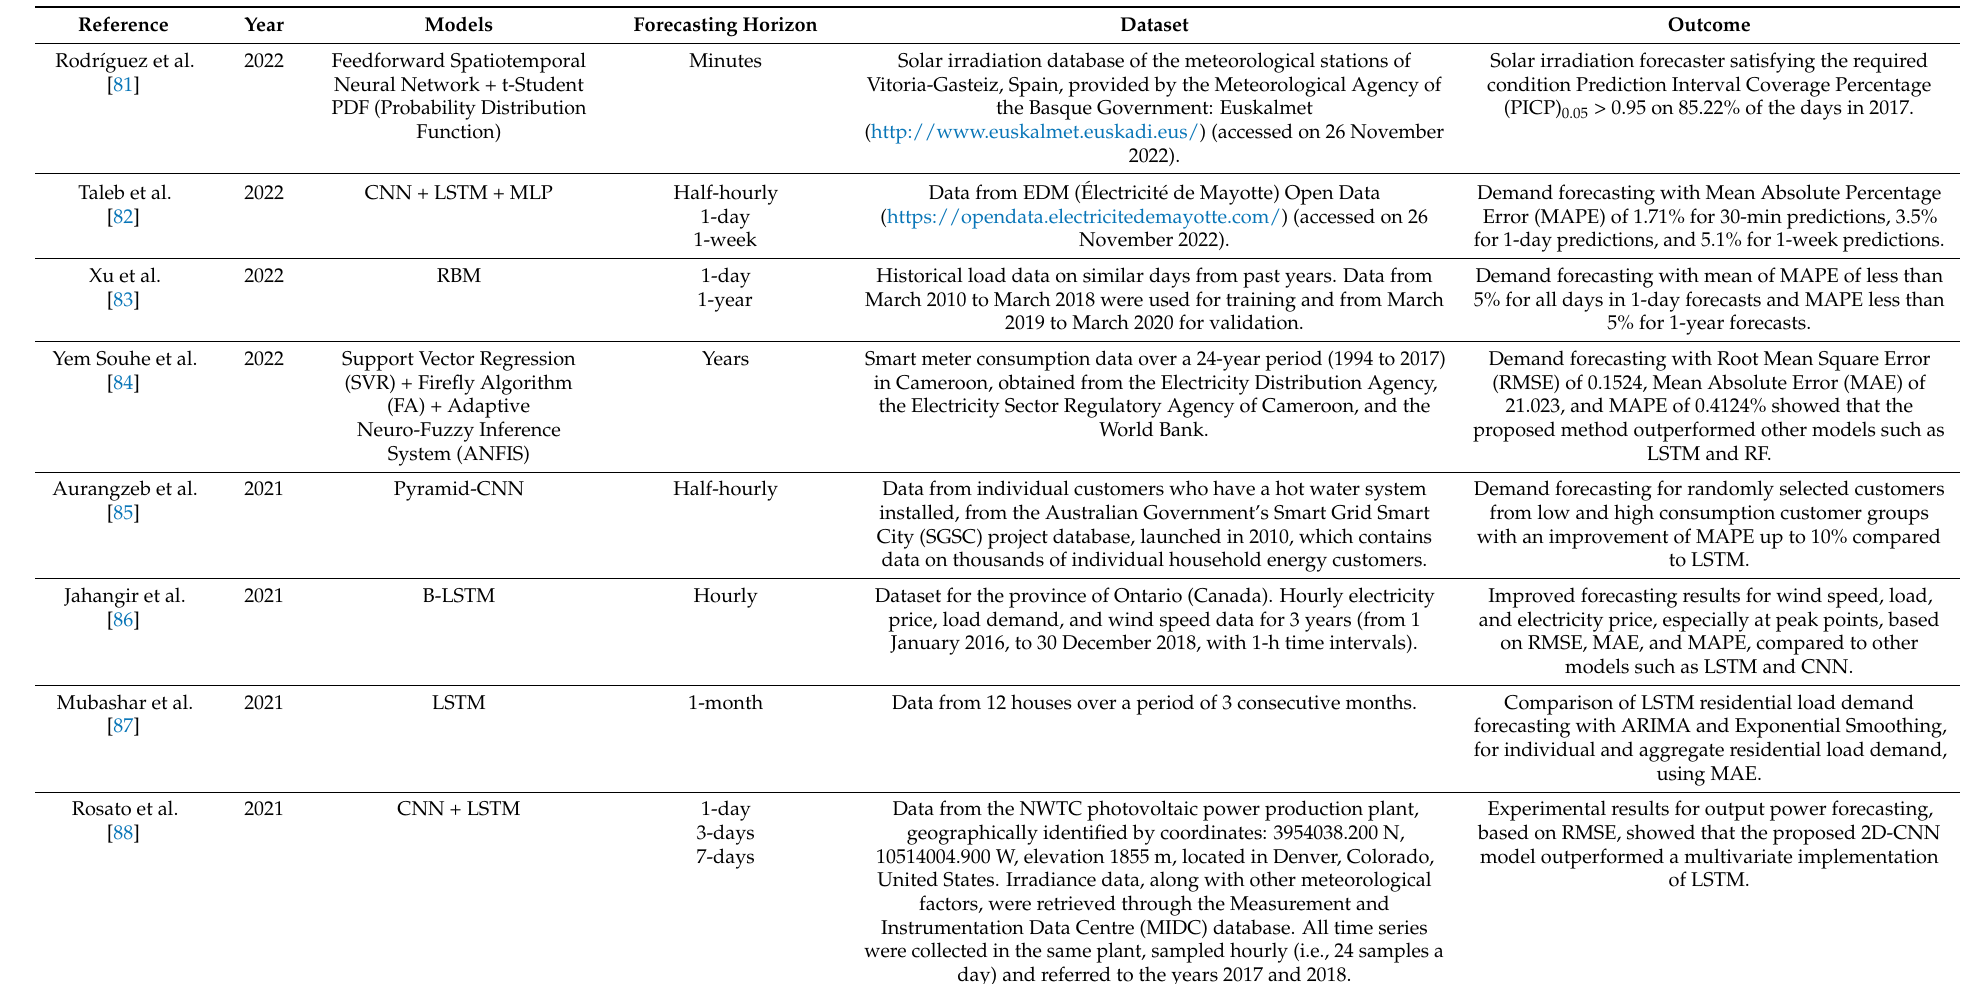
Table 5. Examples of application of Deep Learning techniques in the energy domain, focusing on demand/load